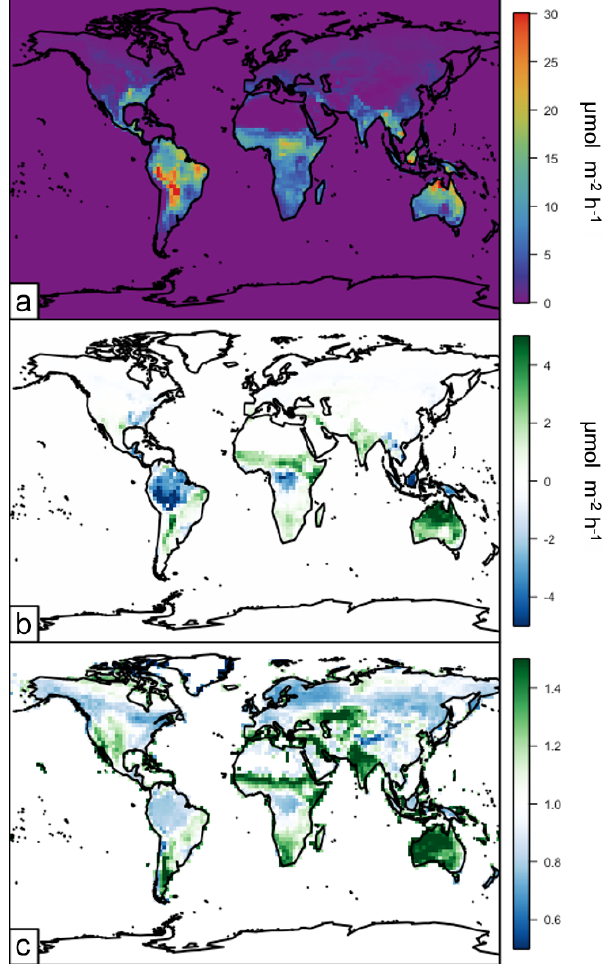
Figure 9. Annual average (2012) isoprene emissions simulated in GEOS-Chem driven by the surrogate model canopy physics (MEGAN Canopy ). Panel (a) shows the annual average emissions. Panel (b) shows the difference between the surrogate model and the base version of simulated emissions. Panel (c) shows the rela- tive difference between the surrogate model and the base version of simulated emissions (surrogate–base model).